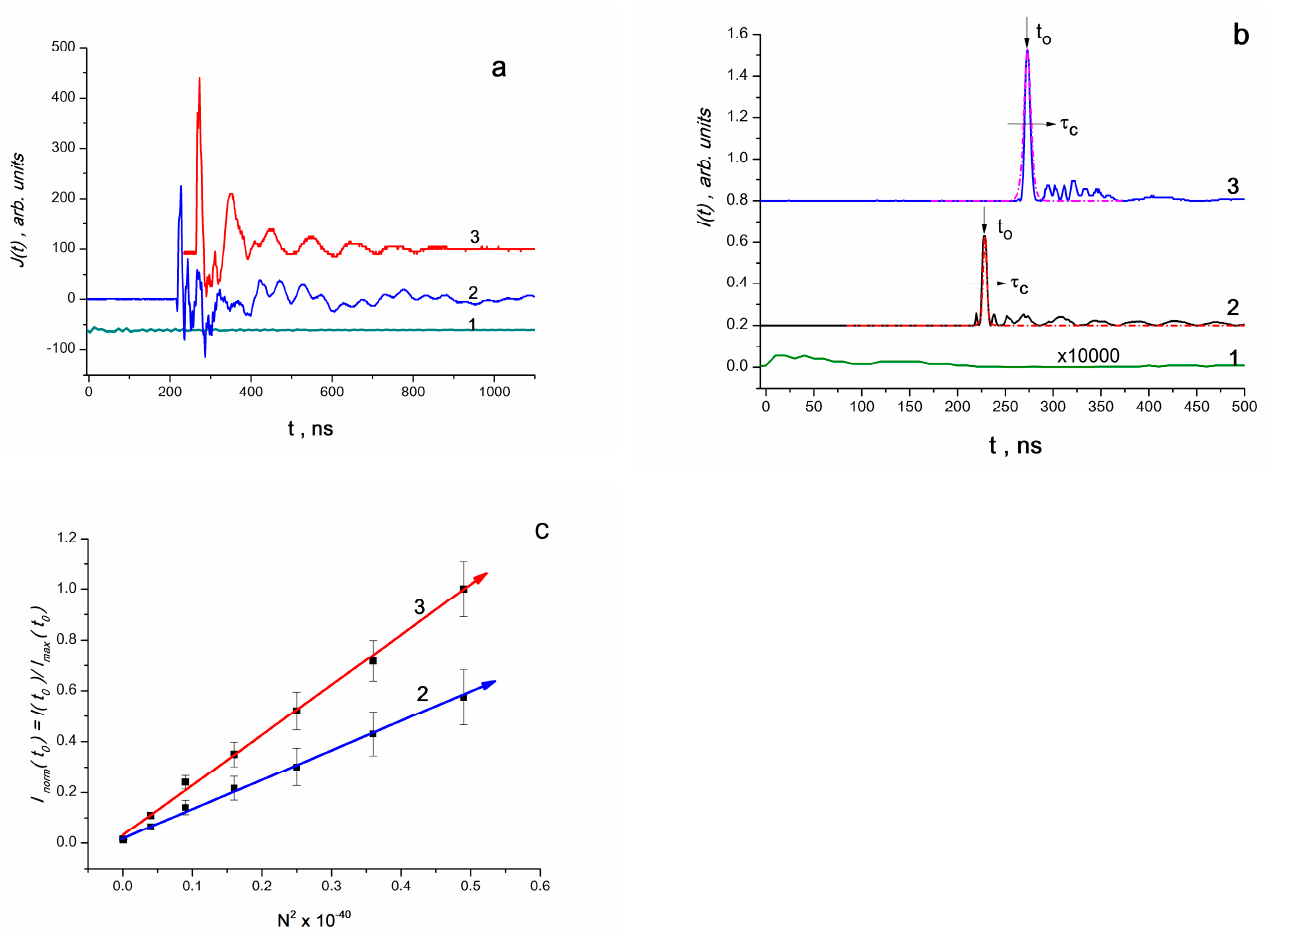
Figure 6. ( a ) time scan of the electrical signal J ( t )~ E ( t ) for PS matrix (1) and samples containing BC Co (2) and BC Mn (3); ( b ) time scan of the normalized signals I ( t )~[ E ( t )] 2 for PS matrix (1) and samples containing BC Co (2) and BC Mn (3); ( c ) is the normalized dependence of I ( t 0 ) on the square of the concentration of complexes in 1 cm 3 of the composite (From [48] with permission).